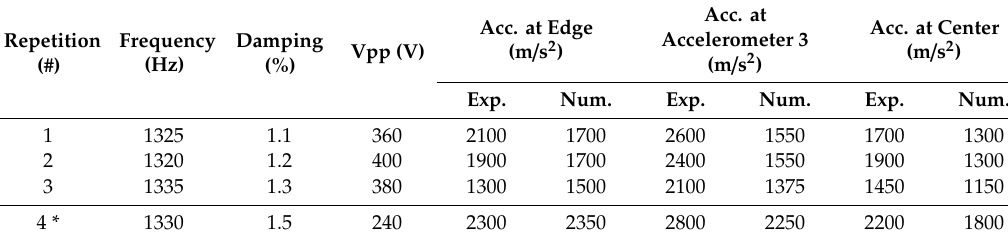
Table 5. Results of test repetitions for mode 23.